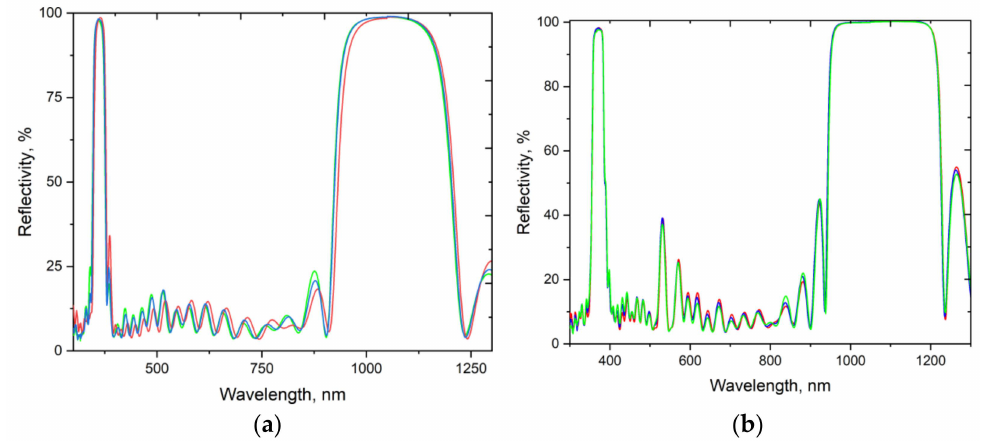
Figure 5. Reflectivity spectra of HfO 2 /SiO 2 ( a ) and ZrO 2 /SiO 2 ( b ) coatings: original (green), irradi- ated in neon (red) and irradiated in air (blue).